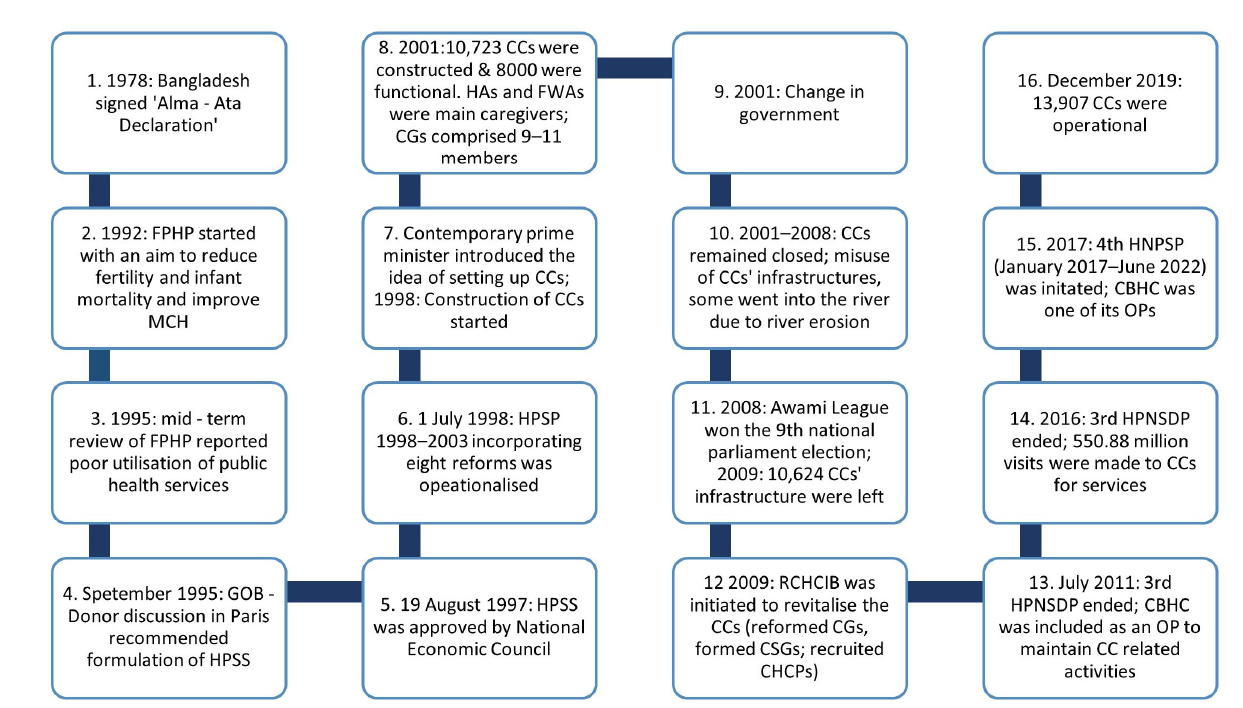
Figure 1. Timeline of the CC journey in Bangladesh.